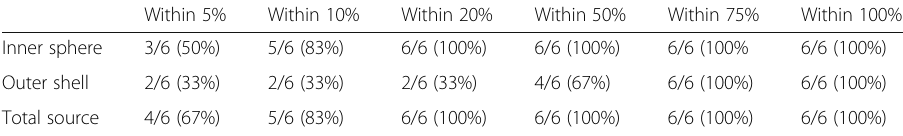
Table 4 Proportion of sites for which reported uncertainty on the measured activity was within the given percentage of the true value. Since H6 did not report an uncertainty, the data from H6 has been excluded from this table Within 5% Within 10% Within